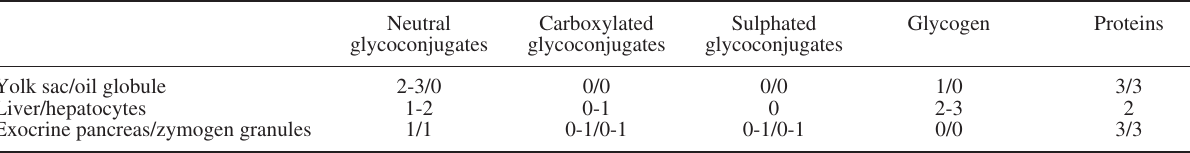
Table 2. – Histochemical distribution of glycoconjugates and proteins in Merluccius merluccius larvae from hatching until 6 dph. Reaction colour intensity: 0, negative; 1, weak; 2, moderate; 3, strong.